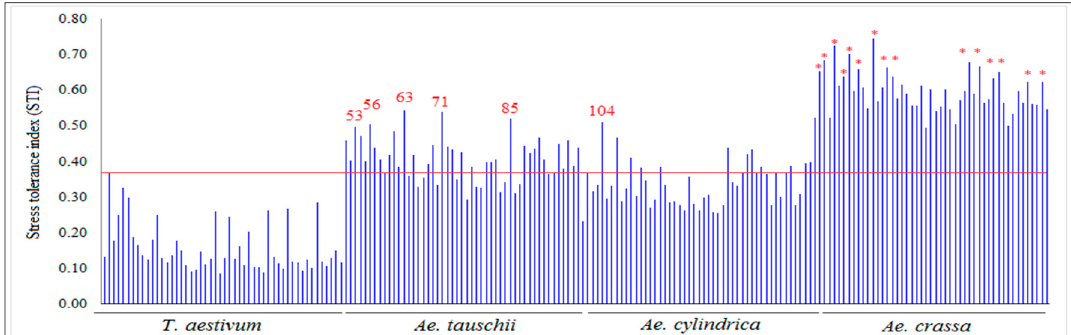
Figure 2. Stress tolerance index (STI) values for the 196 accessions possessing the D genome. Red line indicates the median value. The accession numbers 53, 56, 63, 71, 85 and 104 represent the most tolerant accessions belonging to Ae. tauschii and Ae. cylindrica species. Stars indicate the accessions with highest STI values (from the left, accession numbers 149, 150, 152, 154, 155, 157, 160, 163, 164, 180, 182, 185, 186, 192 and 195).